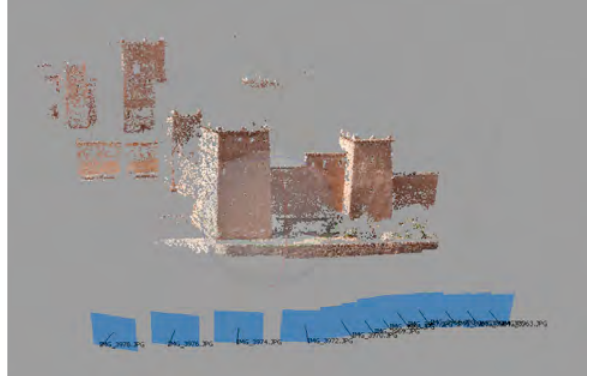
Figure 3: PhotoScan model of the Kasbah, image courtesy of B. Van Genechten.